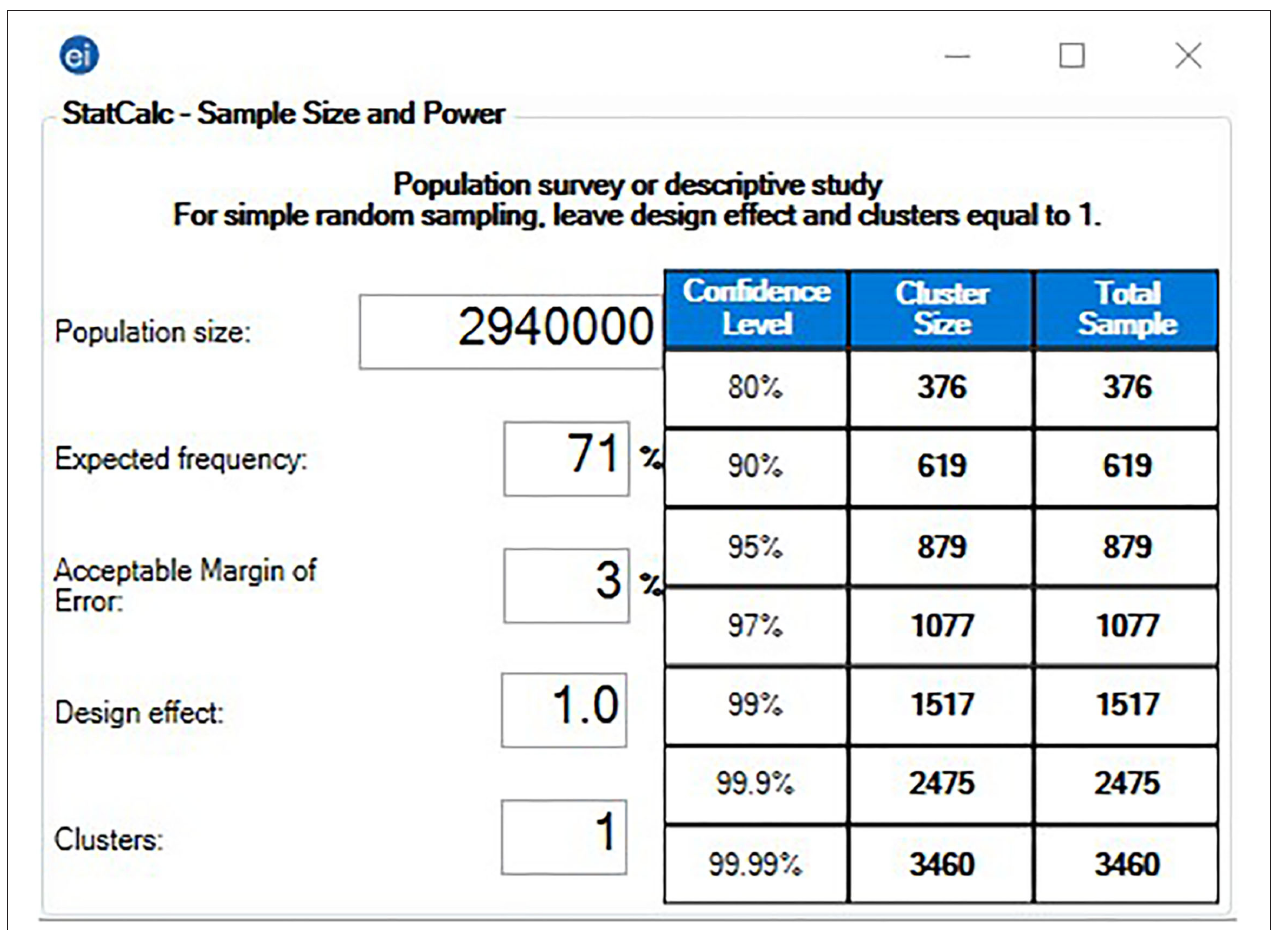
FIGURE 1 | Sample size of german university students and employees—Epi-Info TM version